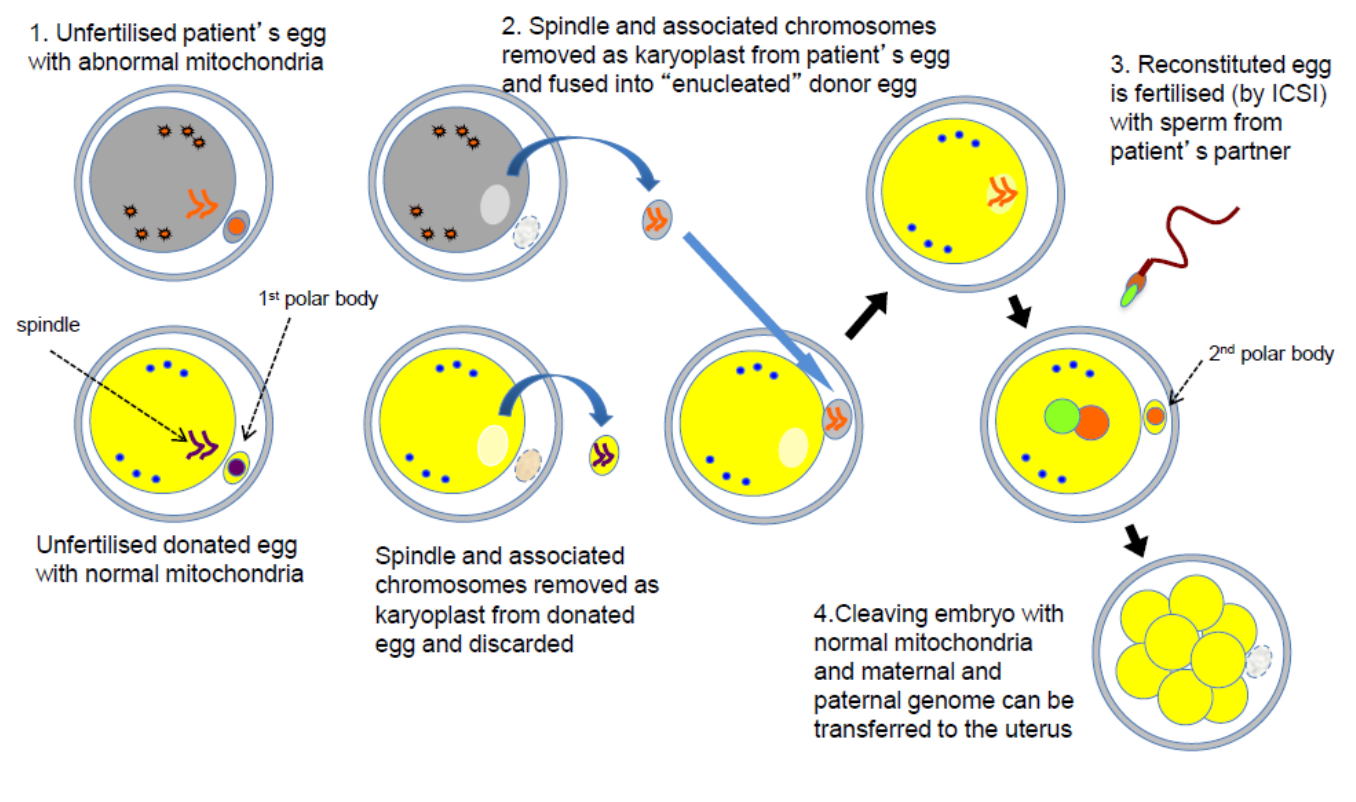
Figure 1. Maternal spindle transfer